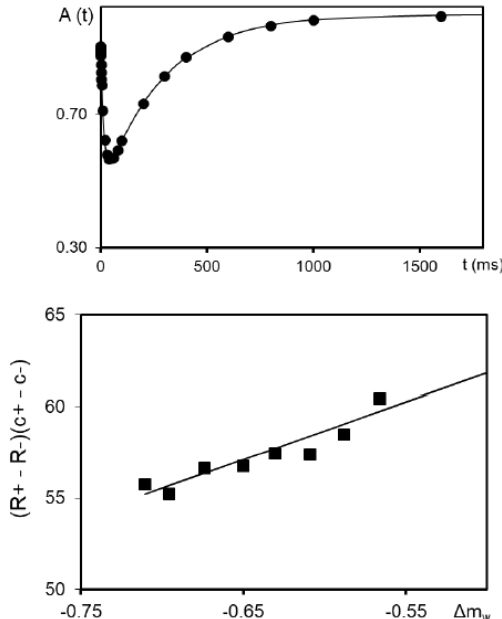
Figure 4. top : The intensity of water protons as a function of spacing t between the 2nd and 3rd 90 ◦ pulses in GS sequence 90 ◦ x – τ 0 –90 ◦ − x – t –90 ◦ x for the spruce sample with water content of 0.03 g H 2 O per g dry matter at τ 0 = 65 µ s. Solid line is fitting the data to Equations (3)–(7) characterizing CR effect [7,19,20]. T = 298 K, frequency = 400 MHz. bottom : Determination of C and k w using the function ( R + − R − )( c + − c − ) in GS experiment.